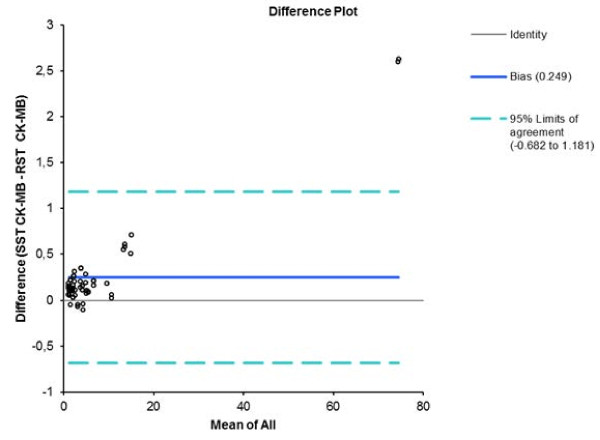
Bland-Altman plot of SST and RST tube CK-MB results showing the 95% limits of agreement.